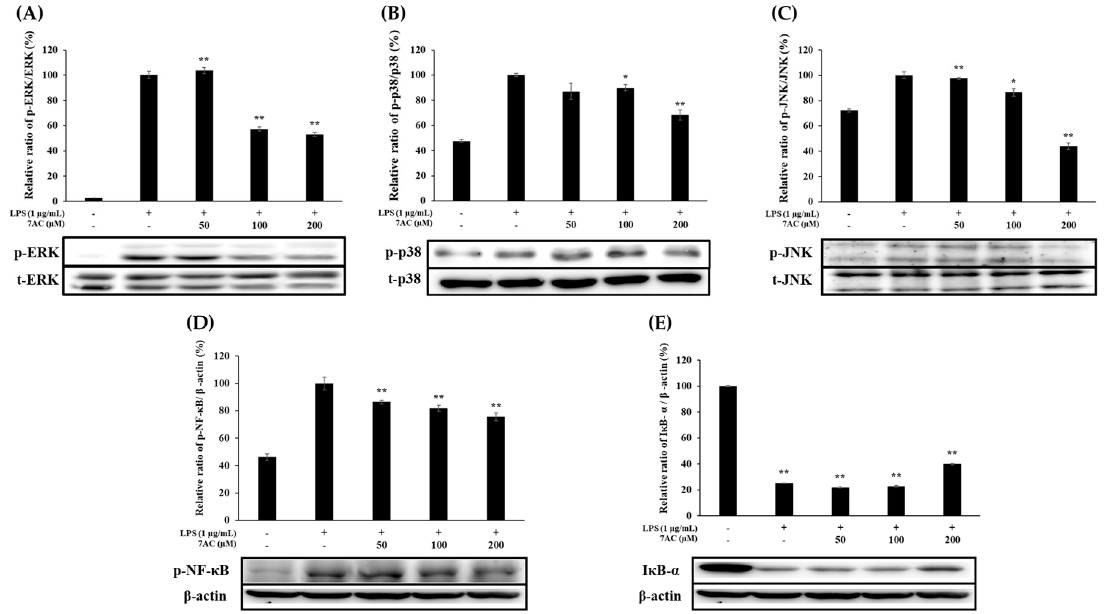
Figure 5. Effect of 7AC on the protein levels of ( A ) ERK, ( B ) p38, ( C ) JNK, ( D ) NF- κ B and ( E ) I κ B kinase in LPS-stimulated RAW 264.7 cells. Cells (5.0 × 10 5 cell/mL) were stimulated with LPS (1 μ g/mL) in the presence of 7AC (50, 100 and 200 μ M) for 40 min. Whole-cell lysates (20 μ g) were prepared and the protein level was subjected to 10% SDS-PAGE and expressions of MAPK, NF- κ B and β -actin were determined by western blotting. * p < 0.05, ** p < 0.01 versus LPS alone.